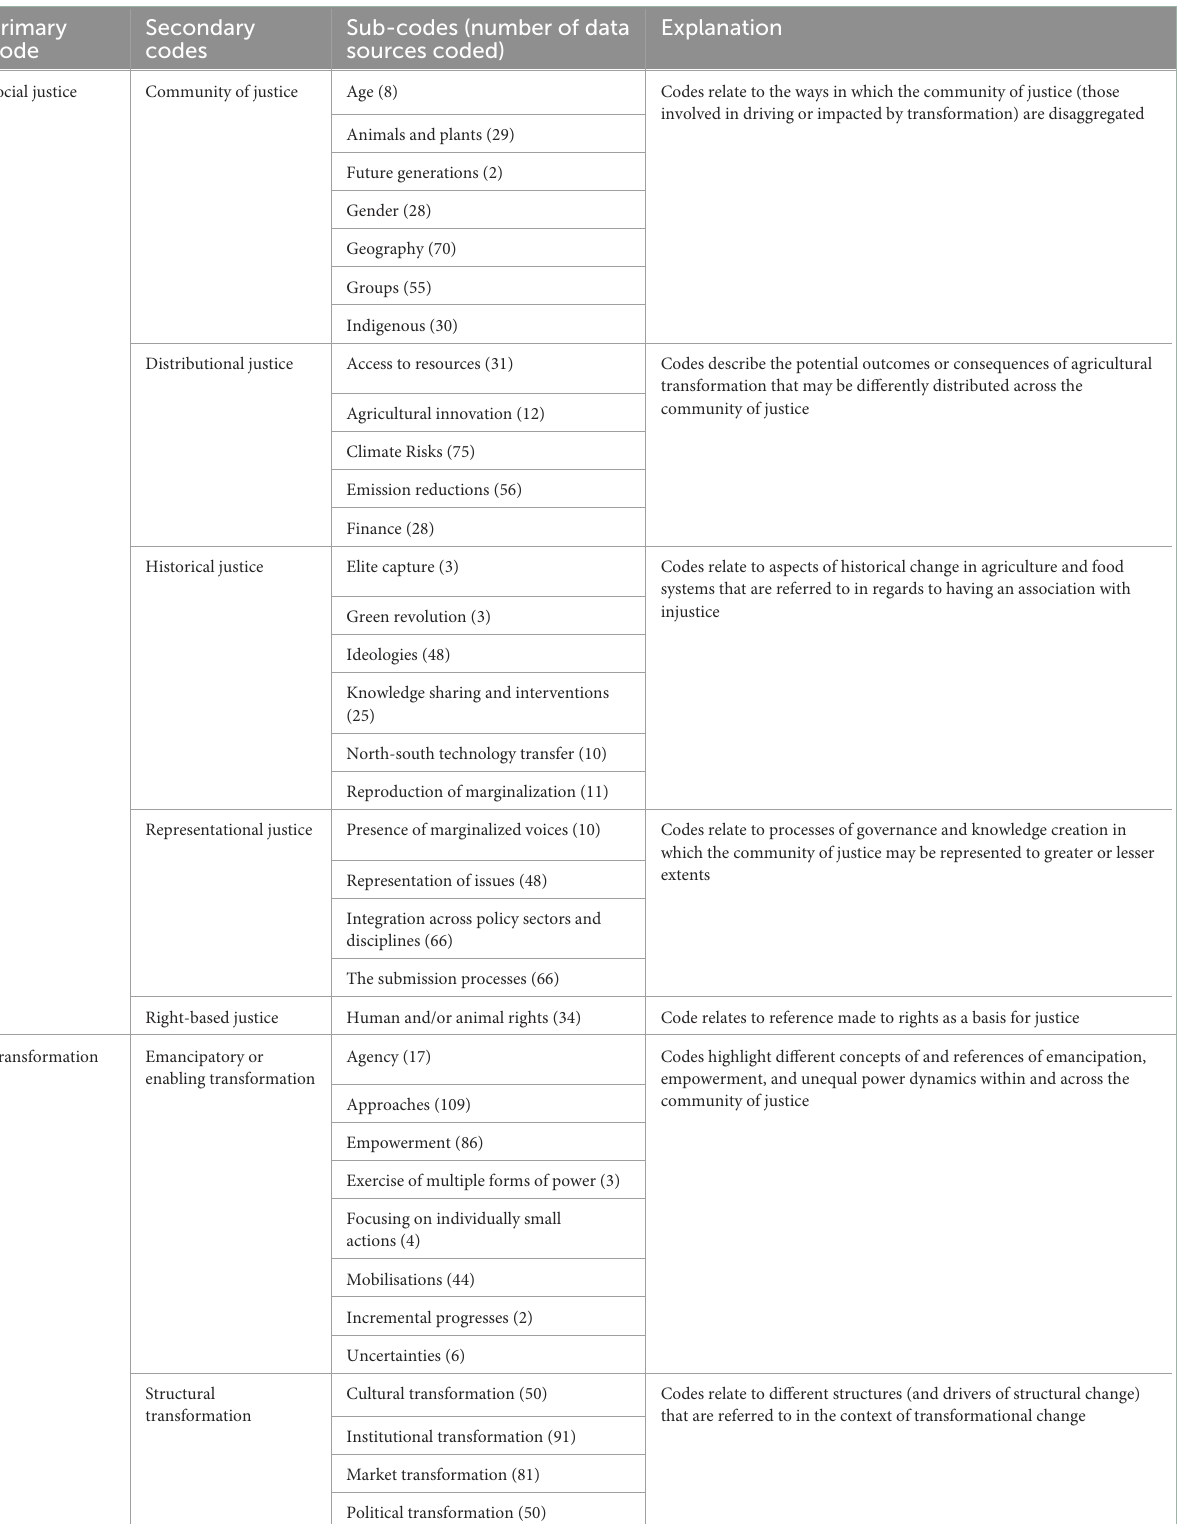
TABLE 1 List of codes applied in analyzing data with an indication of the number of data sources to which each sub code was